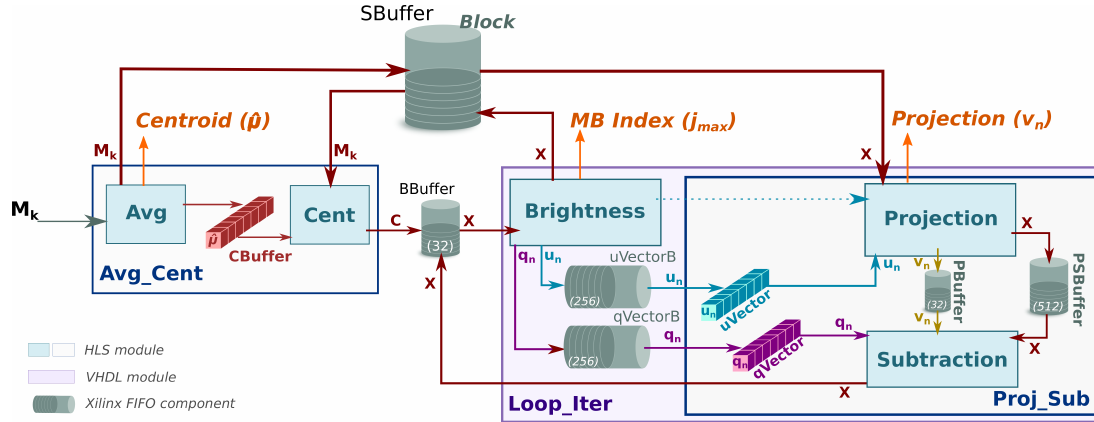
Figure 2. Overview of the HyperLCA Transform hardware accelerator. Light blue and white boxes represent modules implemented using HLS. Light red boxes and FIFOs represent glue logic and memory elements designed and instantiated using VHDL